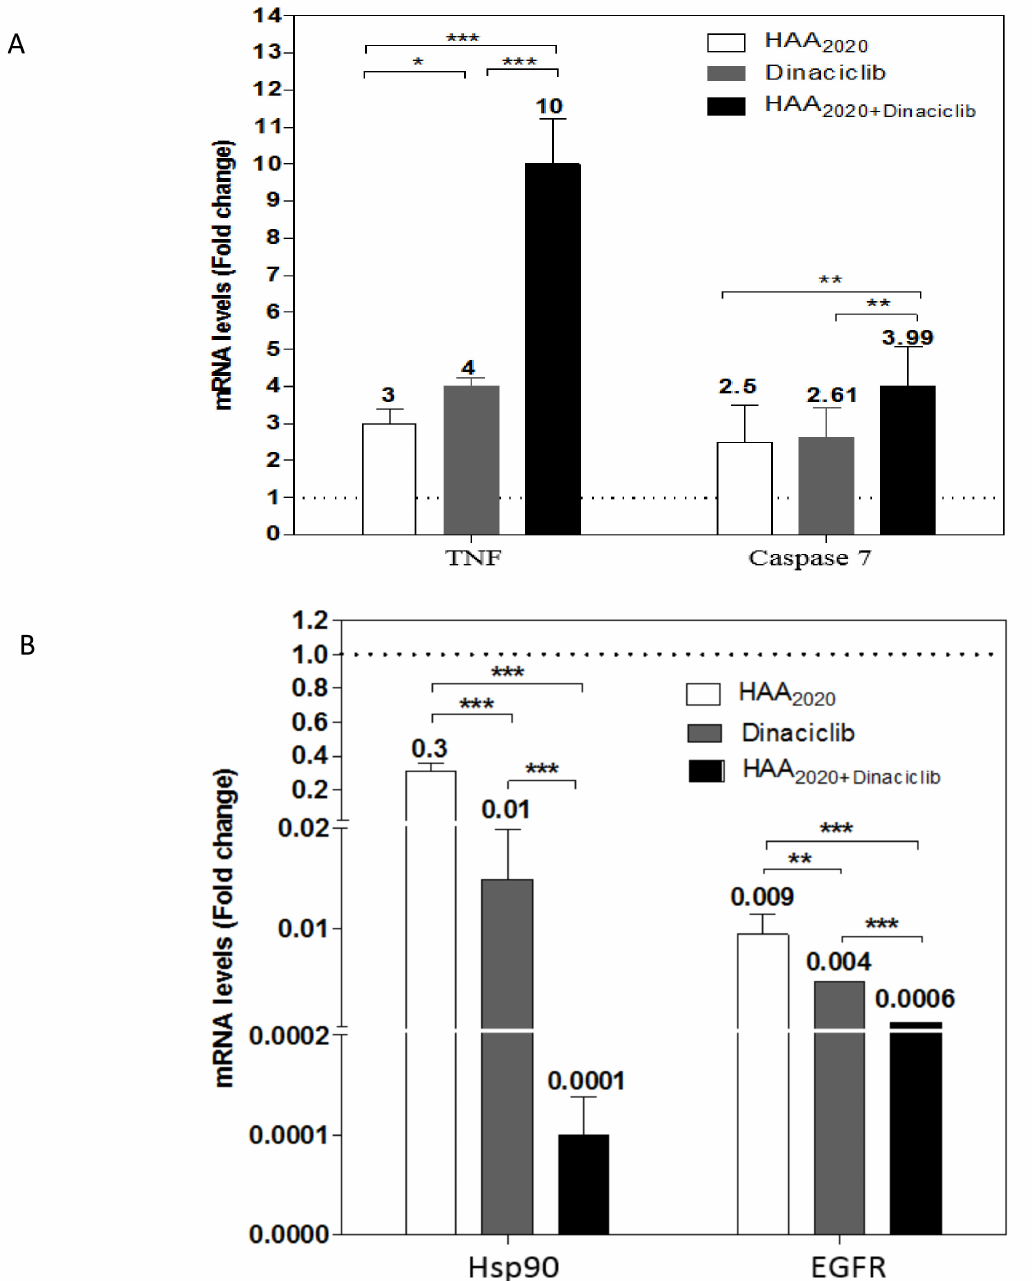
Figure 6. mRNA expression levels of TNF- α and caspase-7 ( A ), Hsp90- α and EGFR ( B ), compared with the control. HL60 cells were treated for 6 h with either HAA 2020 (500 nM), dinaciclib (10 nM) or their combination. Data are represented as mean ± SEM ( n = 3, two independent experiments). The results were expressed as fold-change compared with the untreated group. Statistical di ff erences, compared with the untreated control cells (dashed line), were assessed by a one-way ANOVA with the Tukey’s post-hoc multiple comparison test. p < 0.05 (*), p < 0.01 (**) and p < 0.001 (***) were taken as